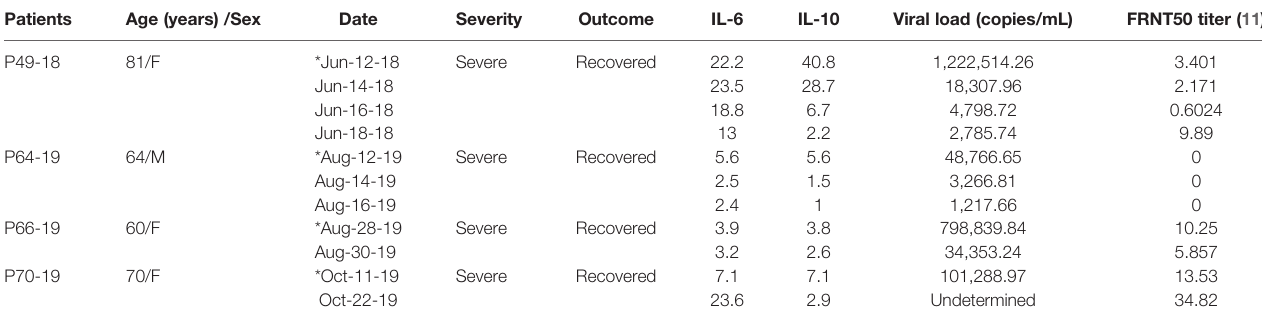
TABLE 3-2 | Kinetics of IL-6 and IL-10 concentrations, viral load, and neutralizing antibody titers in patients with nonfatal severe disease.